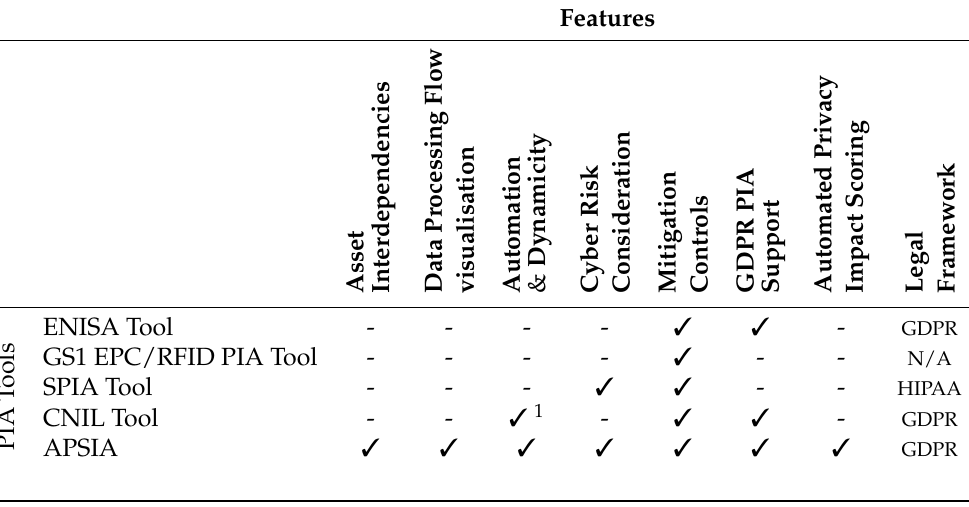
Table 1. Comparison of